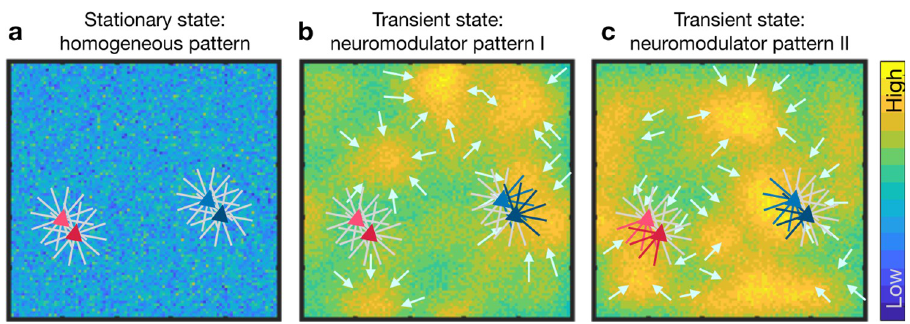
Fig 9. Dynamic reorganization of activity sequences in a recurrent network. (a) Schematic of a network in which neurons connect in all direction equally. The blue background shows the baseline level of a certain neuromodulator substance. Two pairs of neurons (blue and red triangles) are shown, the axons of which project in all directions uniformly. This is equivalent to the symmetric configuration and, hence, no sequential activity will emerge. (b) Non- uniform distribution of concentration of the neuromodulator in different parts of the network, as indicated by the colormap. The colored lines indicate the enhanced synaptic strength in specific directions. Asymmetric connectivity of neighboring neurons caused by such non-uniform neuromodulator concentration distribution may result in activity sequence in some regions of the network (e.g. neurons marked in blue). The short arrows mark the potential flow of a neuronal activity sequence along the spatial gradient of the neuromodulator concentration. (c) Same as in b for a different pattern of neuromodulator concentration which may lead to a different flow of neuronal activity, resulting in the appearance of activity sequences in a new set of neurons (e.g. those marked in red) and a change in direction of the sequence in others (e.g. those marked in blue).